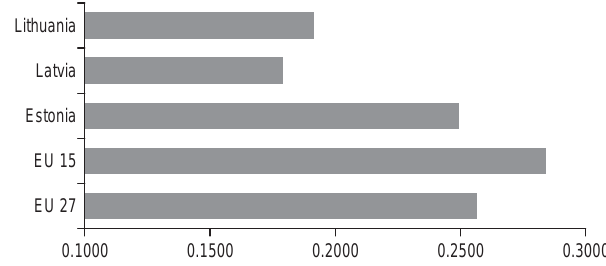
Fig. 3. Aggregated assessment of Baltic countries in the EU context during the averaged period of 2004–2008 (the second situation). Data source: Eurostat, Transparency international, The Heritage Foundation, computed by authors